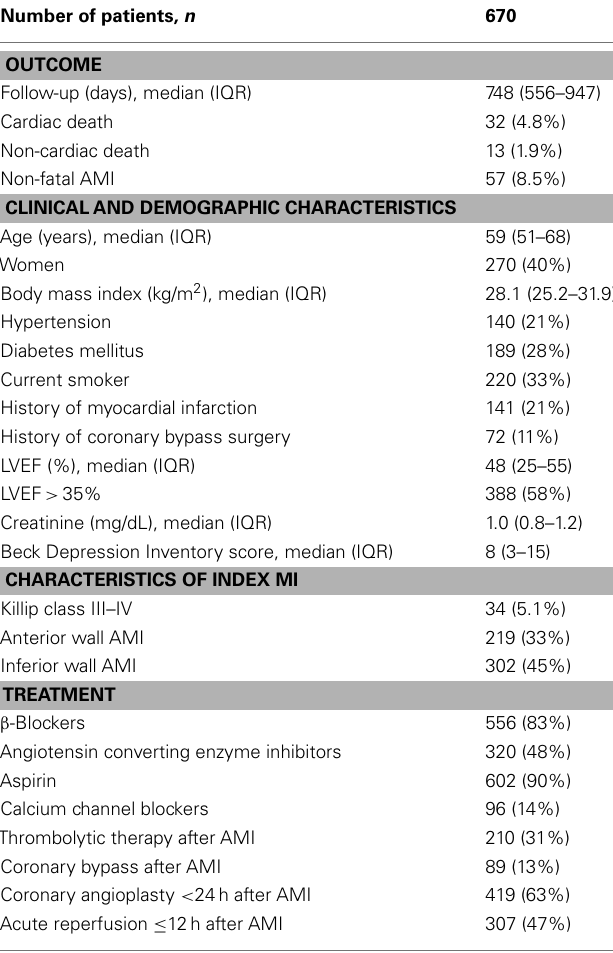
Table 1 | Characteristics of